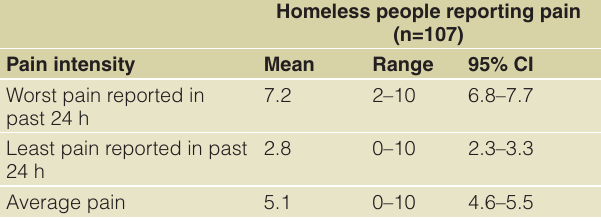
Table 1. The severity of pain experienced by participants in the previous 24 hours, on a numerical rating scale from 0 to 10.